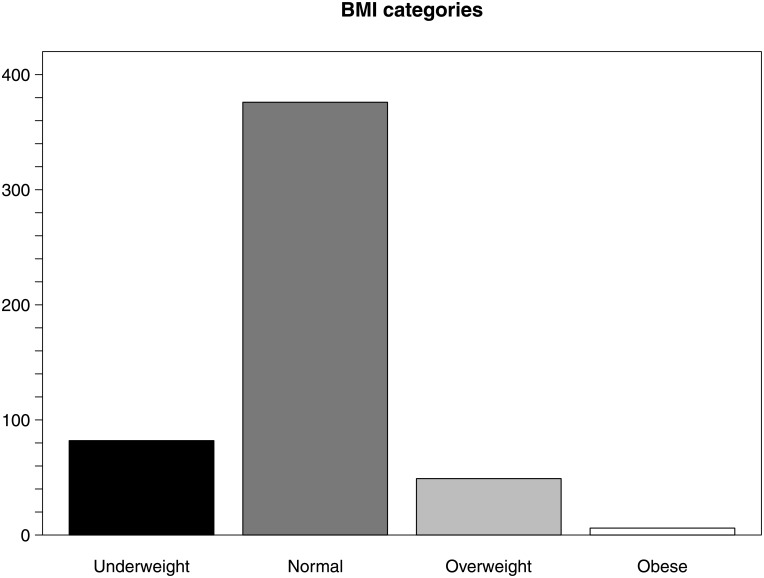
Histogram of individuals in each BMI category.Underweight (<18.5 kg/m2) = 16%; normal (≥18.5 to <25 kg/m2) = 73.3%; overweight (25–30 kg/m2) = 9.5%; obese (≥30 kg/m2) = 1.2%.